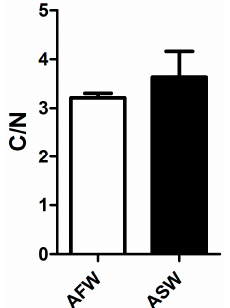
Figure 7. Carbon to nitrogen ratio in the muscle of European sea bass in the two groups (AFW and ASW). Bars indicate SD. Total lipids, monounsaturated fatty acids (MUFAs) and polyunsaturated fatty acids (PUFAs) were not statistically different, while saturated fatty acids (SFAs) reported a significant decrease ( p < 0.05) in D. labrax reared in AFW with respect to fish farmed in ASW (Table 4). Also, arachidonic